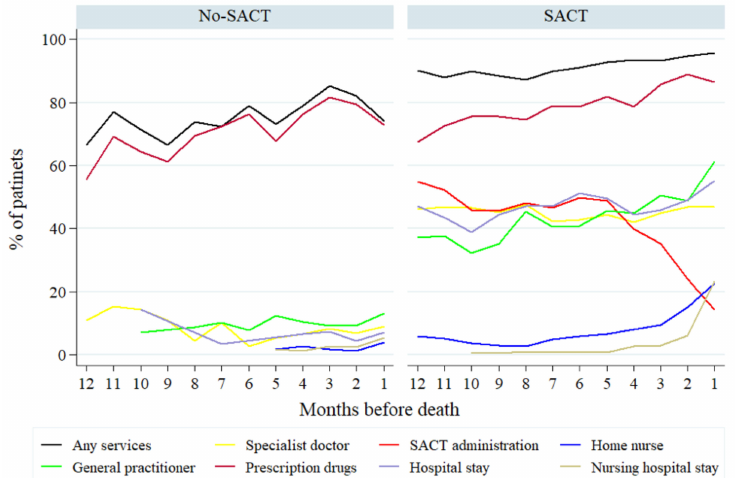
Figure 1. Proportion of patients who received certain health care services by month before death. (SACT, systemic anti-cancer